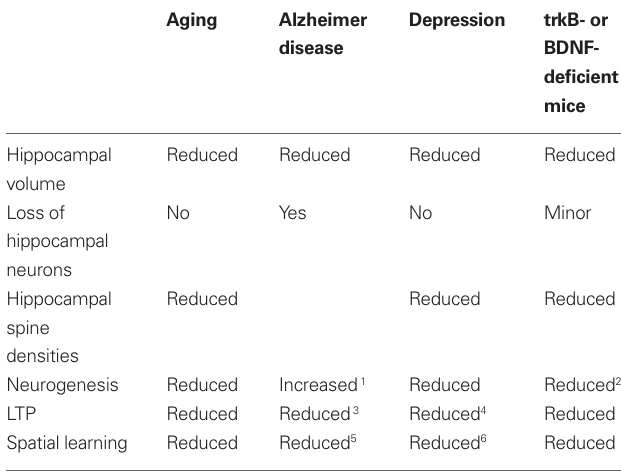
Table 1 | Changes in the hippocampus or in hippocampus-dependent